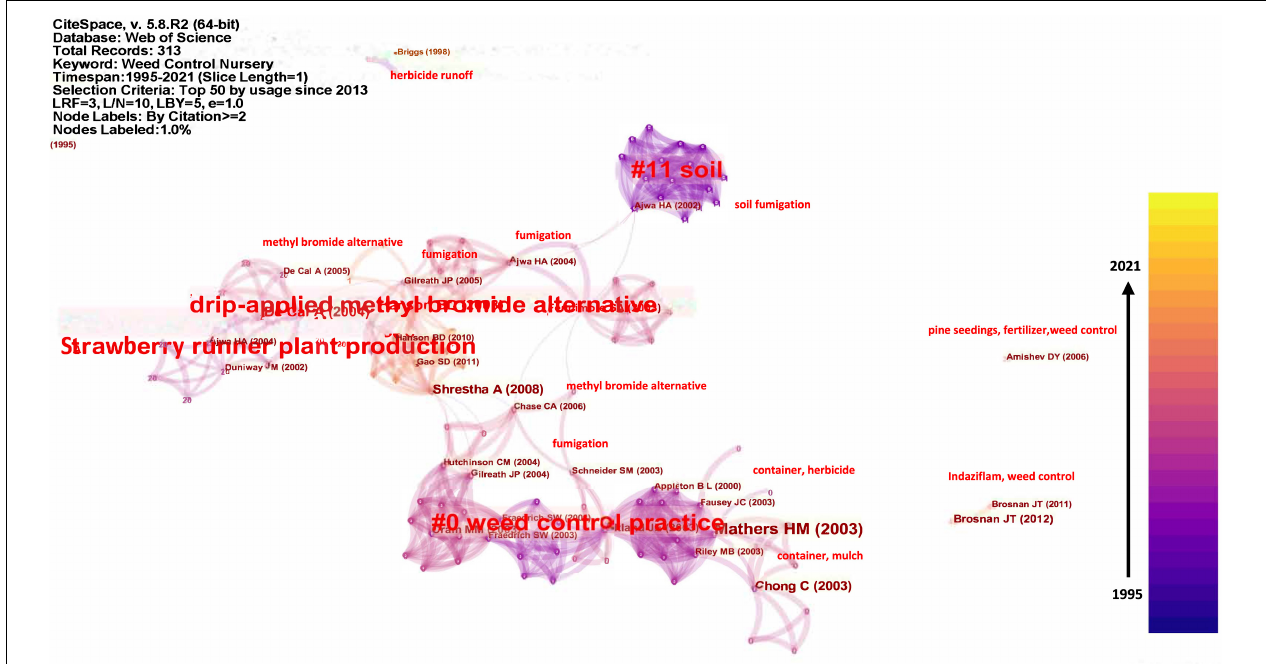
FIGURE 4 | CiteSapce generated knowledge networks on the top 50 pieces of literature used since 2013. The small red texts are keywords derived from the clusters or the literature next to